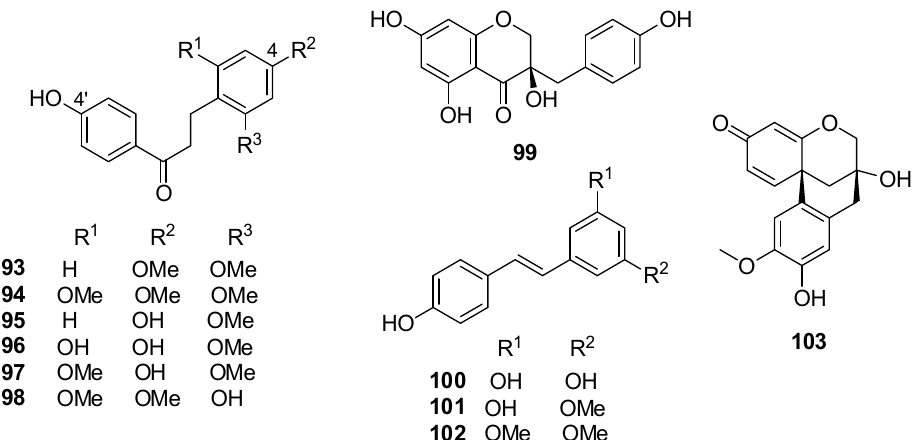
Figure 15. Chemical structures of compounds 93 – 103 isolated from D. loureiri.